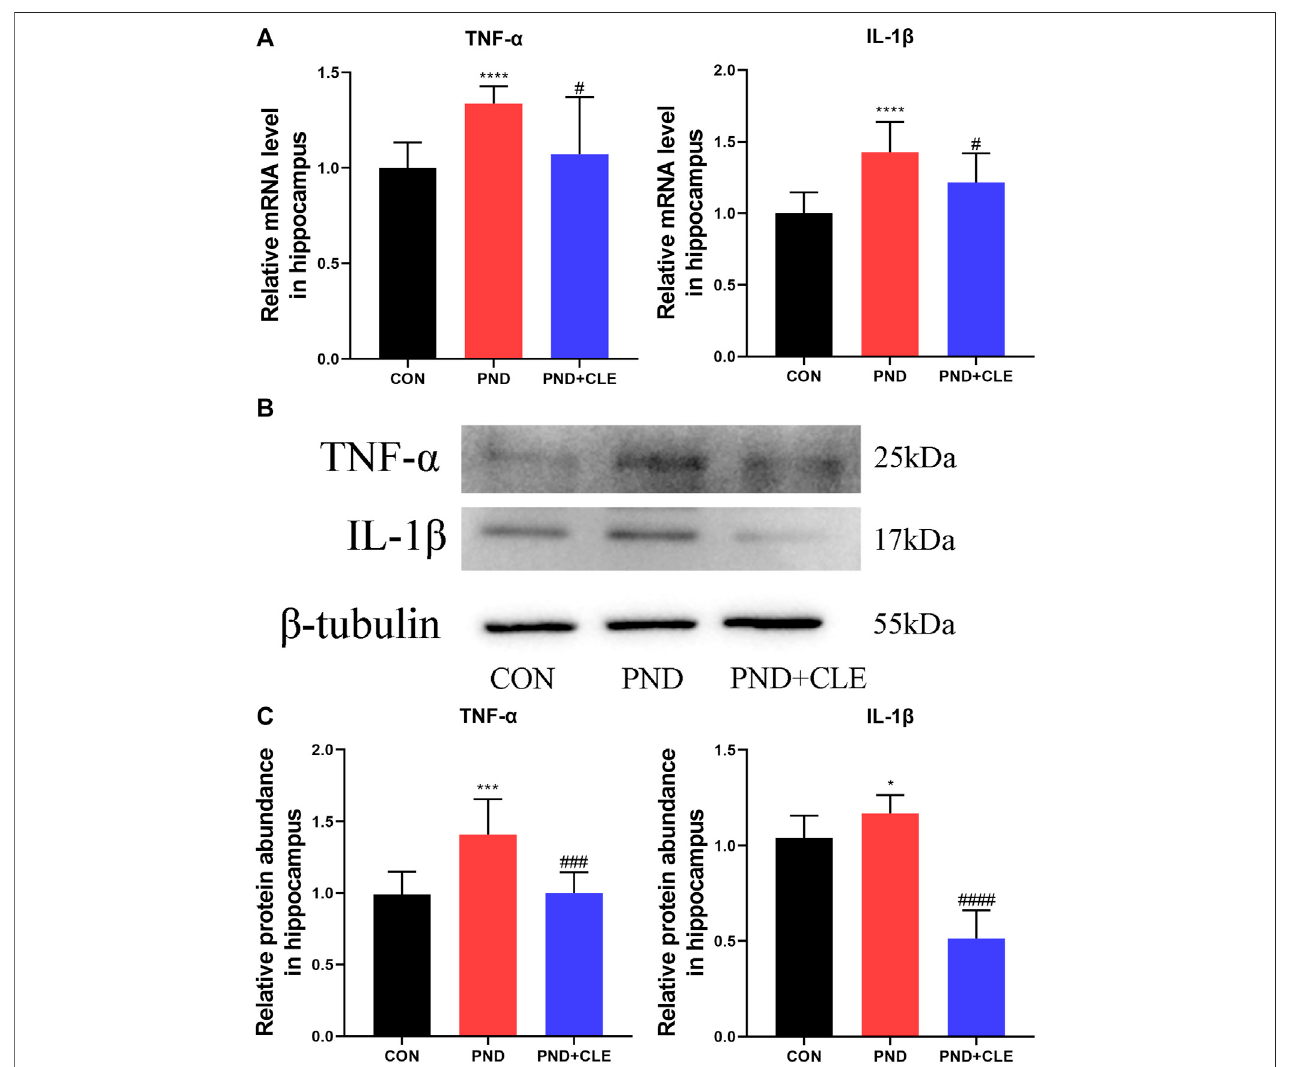
FIGURE 3 | Effects of clemastine on expression levels of in fl ammatory cytokines in hippocampus of aged mice after anesthesia and surgery. ( A ) Relative mRNA expressions of TNF- α and IL-1 β , normalized to that of the GAPDH internal control. ( B ) Representative western blot images of TNF- α and IL-1 β . ( C ) Relative protein expressionsofTNF- α and IL-1 β ,normalizedtothatofthe β -tubulin internal control. Thedata arepresented asmean ± S.D.( n (cid:1) 10mice per group). * p < 0.05 compared with the CON group. *** p < 0.005 compared with the CON group. **** p < 0.001 compared with the CON group. # p < 0.05 compared with the PND group. ### p < 0.005 compared with the PND group. #### p < 0.001 compared with the PND group.